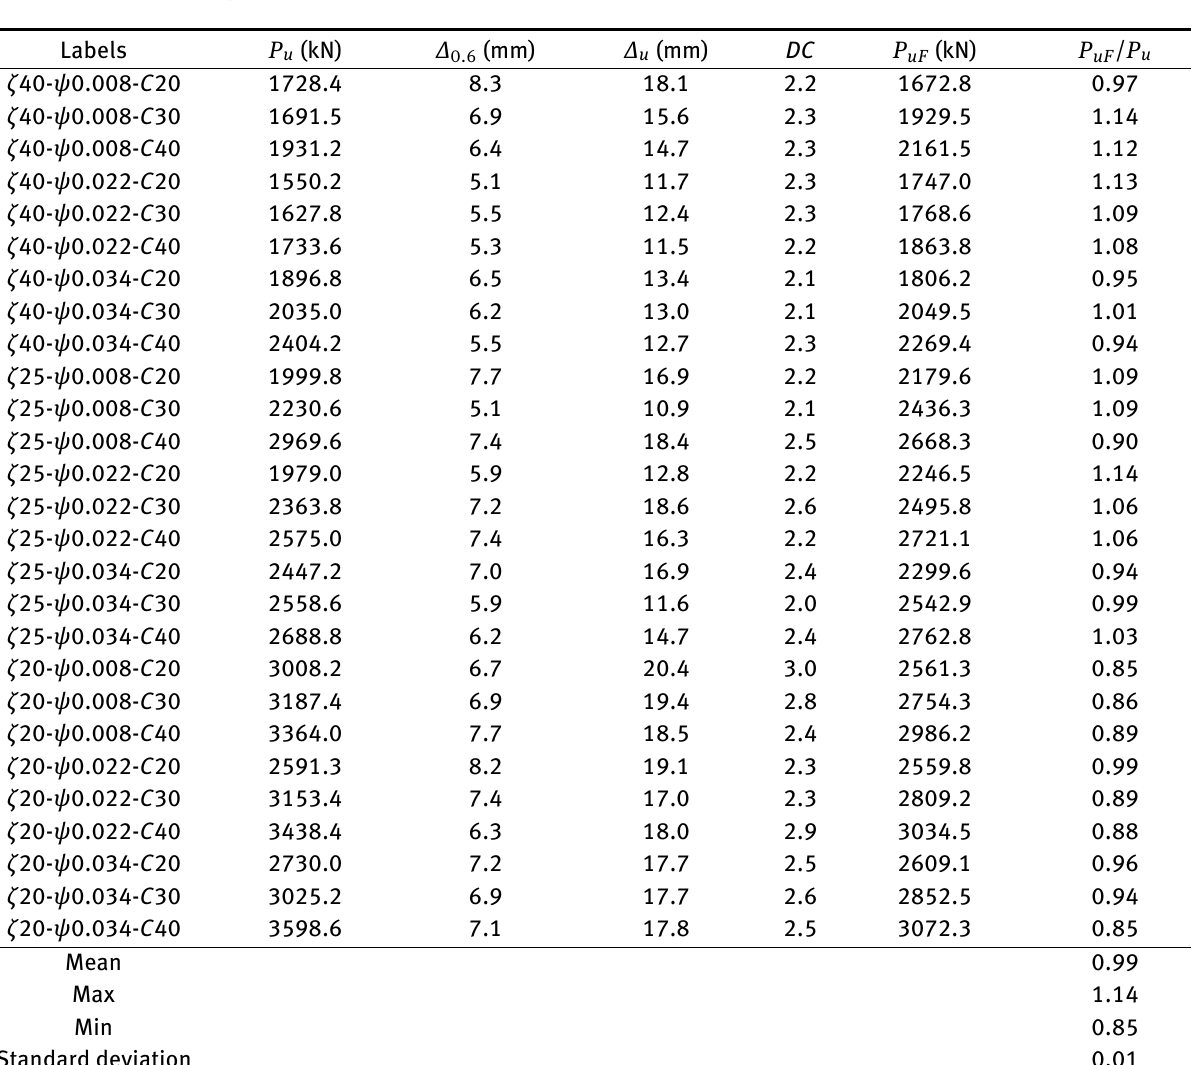
Table 6: Test results for all specimens